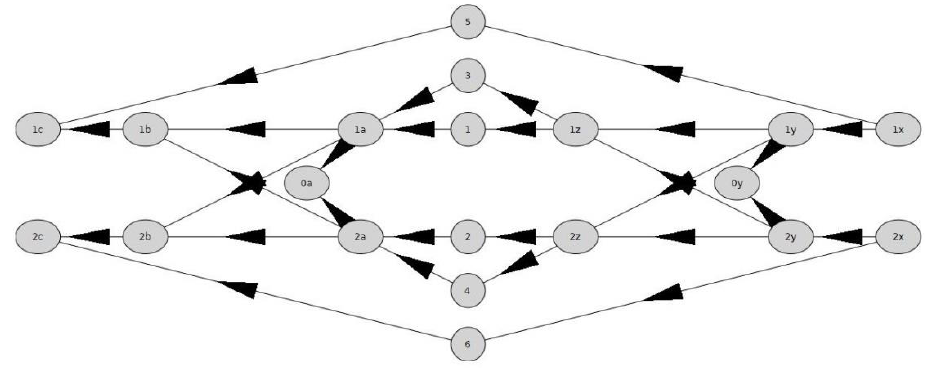
Figure 15. Plot of the digraph associated to the track layout diagram of Figure 13.